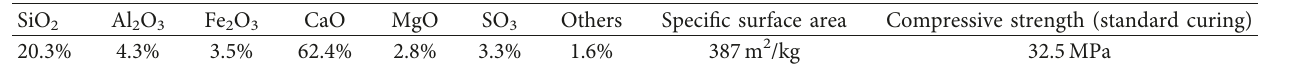
Table 2: Chemical composition and physical properties of cement.